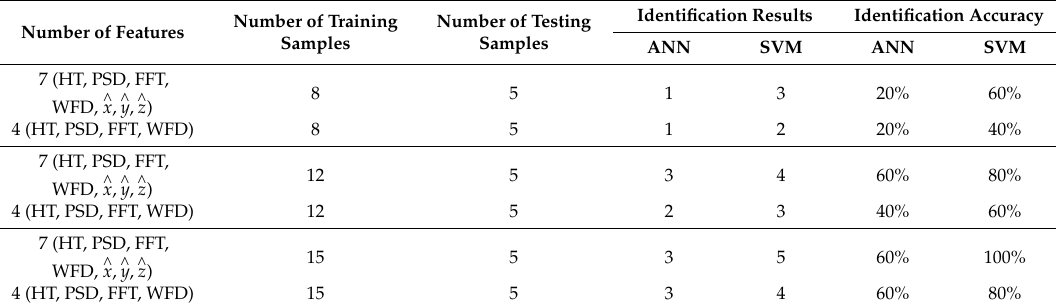
Table 6. Experimental results of damage identification based on multi-feature